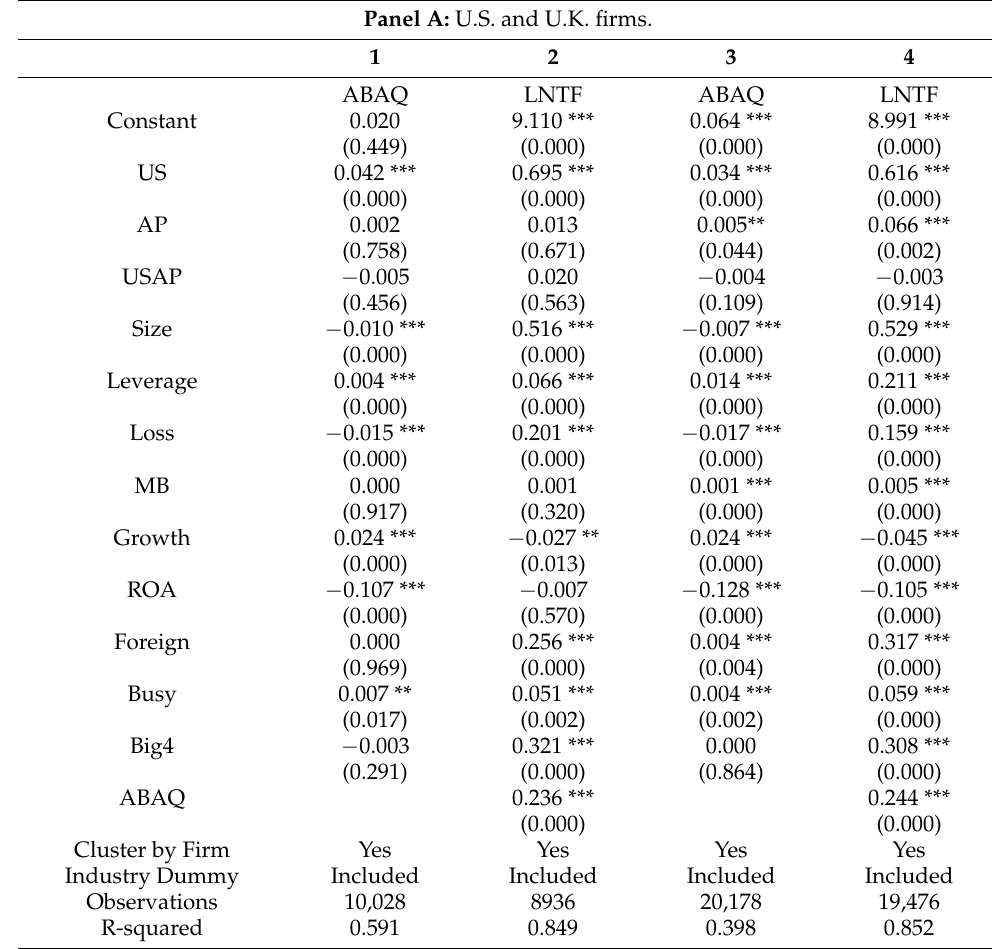
Table 6. Difference-in-difference regressions of the audit quality and audit cost on the implementation of PCAOB Rule 3211 for the U.S. and U.K. firms, both without and with first-differenced data. Panel A: U.S. and U.K. firms.